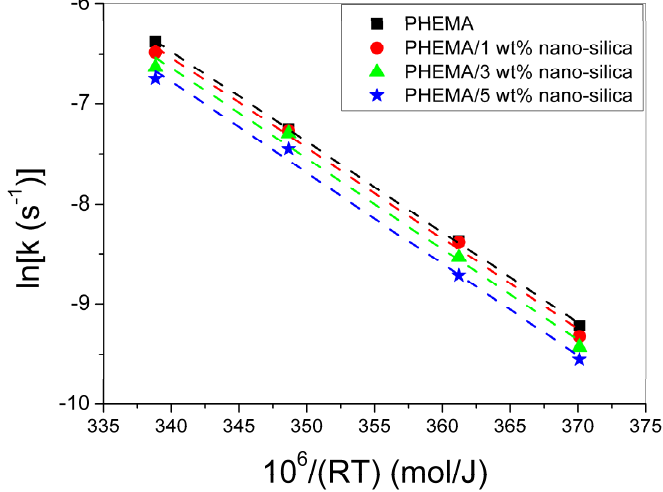
Figure 12. Arrhenius-type plots to calculate the overall (effective) activation energies of PHEMA/nano-silica nanocomposites.